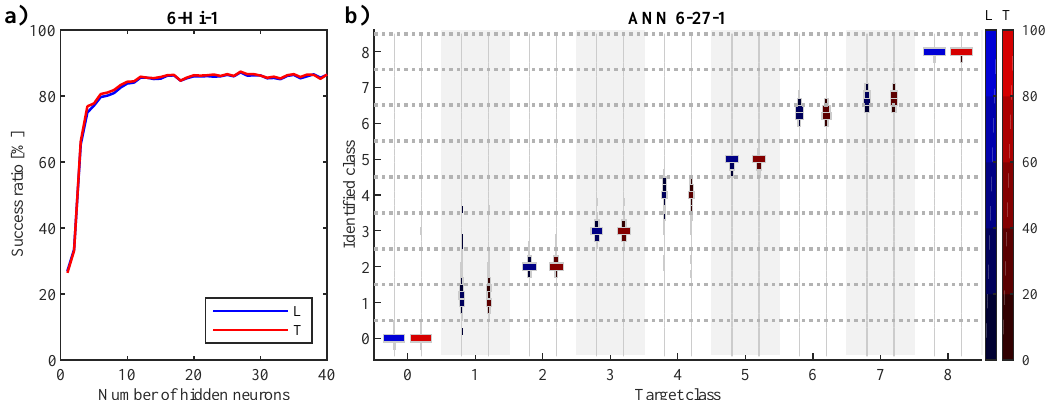
Figure 5. ( a ) Optimization of the hidden neuron number for ANN 6-Hi-1 for anomaly detection and classification based on six affine transformation parameters, ( b ) classification by ANN in architecture 6-27-1, Applied Classes: S00: 0, S33: 1, S22: 2, S23: 3, S44: 4, S34: 5, S14: 6, S11: 7, S12: 8; L: learning;